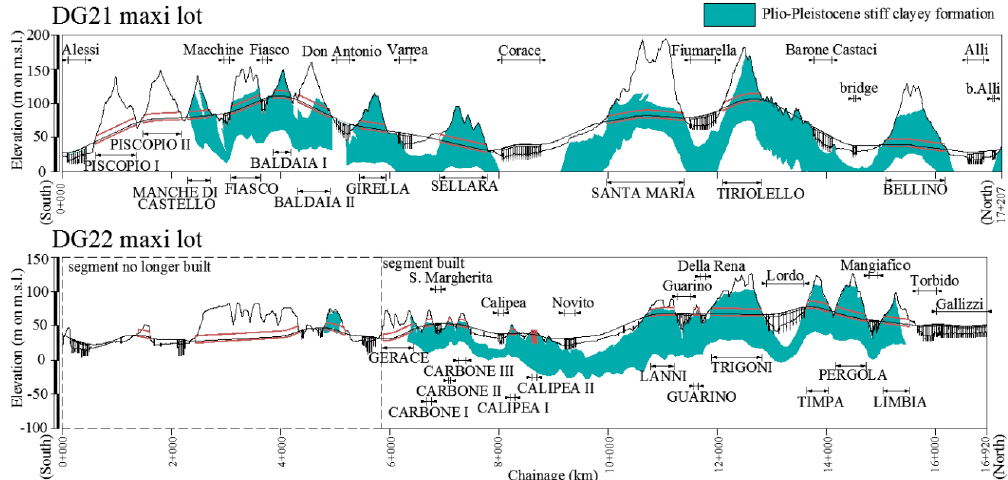
Figure 2. Longitudinal simplified cross-section of the DG21 and DG22 maxi lots with indication of viaducts, bridges (names in lower case in the figure), and tunnels (capital letters).